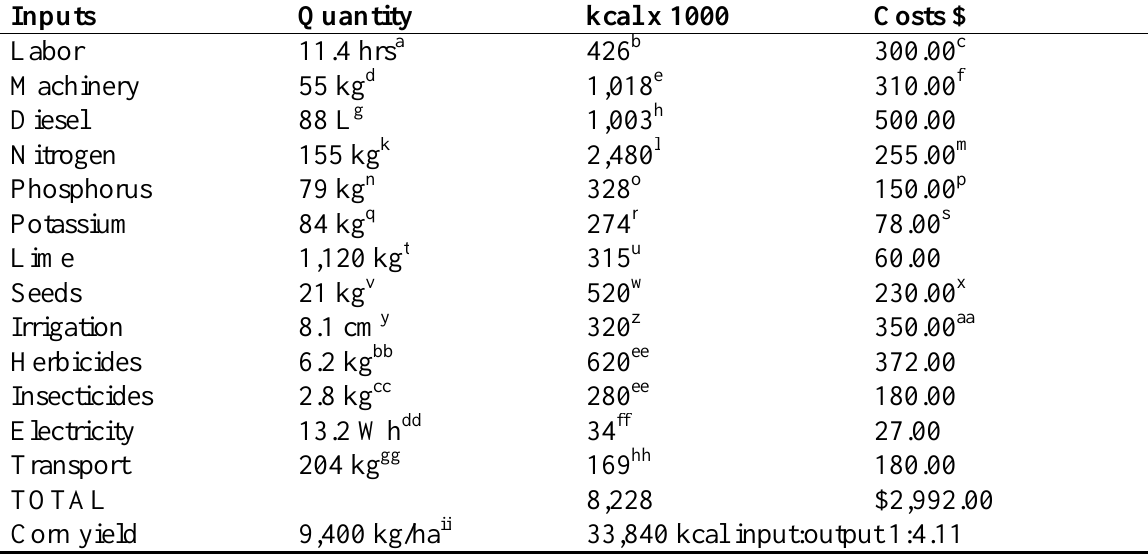
Table 4. Energy inputs and costs of corn production per hectare in the United